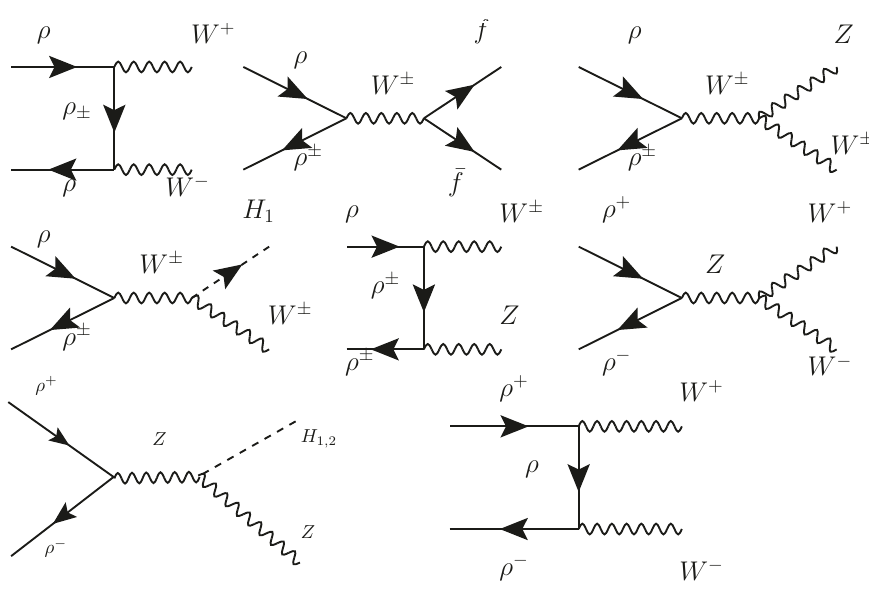
Figure 5 . Annhilation and co-annihilation channels of ρ in the early Universe